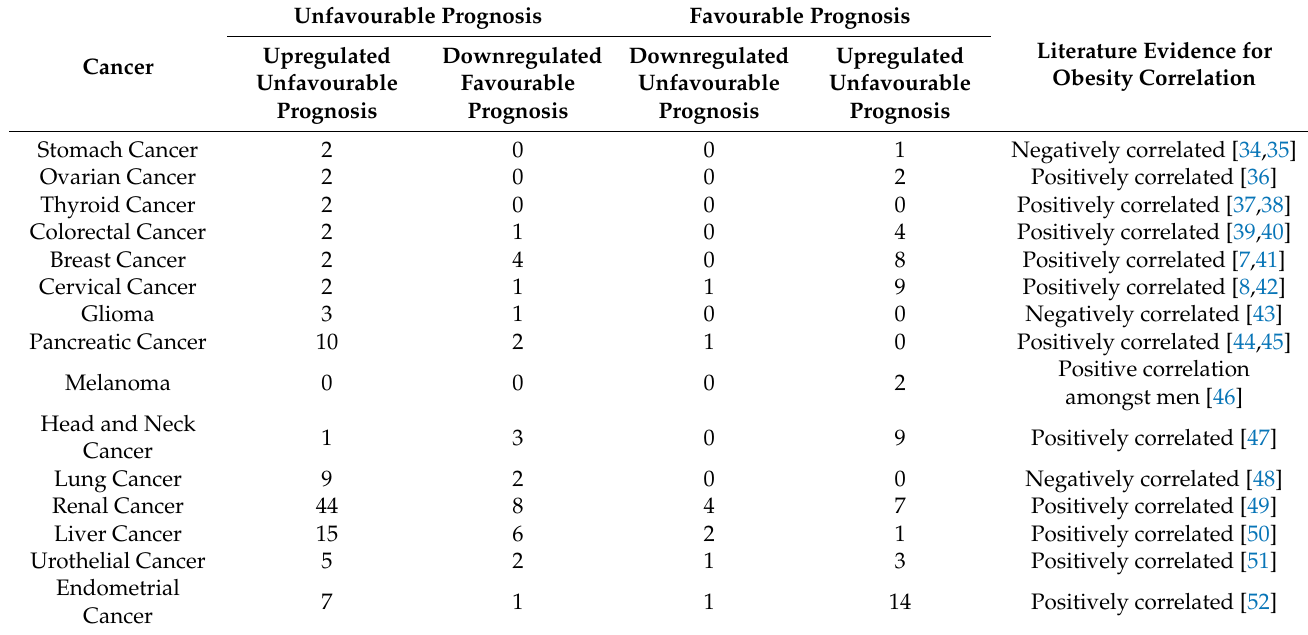
Table 1. Prognosis score associated with each cancer. Unfavorable or favorable prognosis was assessed according to orange or blue edges, respectively. Upregulated or downregulated genes were described according to their log2FC. A bibliographic search was performed to assess previous correlations of each cancer type with